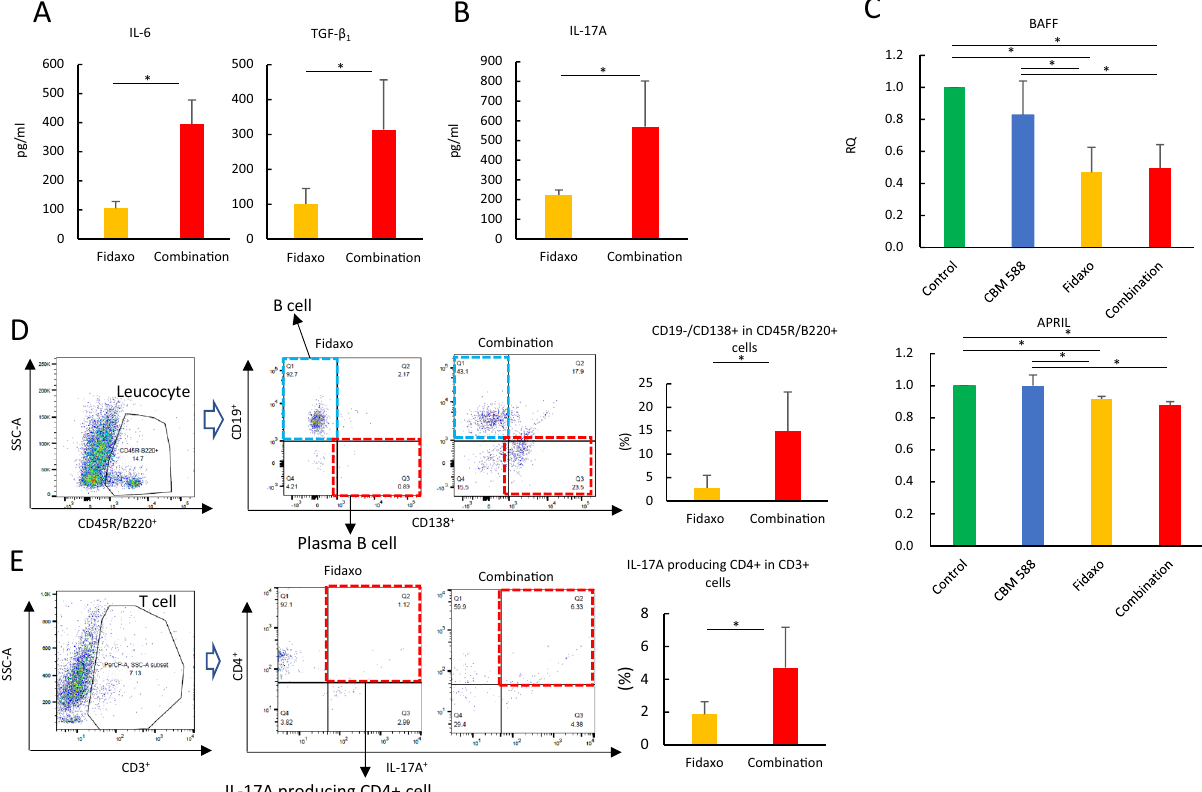
Figure 5. IL-17A plays important role to enhance antibacterial activity of combination therapy with C. butyricum against C. difficile and activate plasma B cell to enhance IgA production. ( A ) Interleukin (IL)-6, Transforming growth factor-β 1 (TGF-β 1 ) and ( B ) IL-17A protein expressions in mice colon lumina propria (cLP) detected at day 8. All values are mean ± SD (n = 5–10). ( C ) The relative RNA expression of genes encoding proliferation-inducing ligand (APRIL) and B-cell activating factor (BAFF) in colon tissues of mice, detected by qPCR. All values are mean ± SD (n = 5–10). ( D ) Representative flow cytometry plots of B cell (CD45R/ B220 + /CD19 + /CD138 - ) and plasma B cell (CD45R/B220 + /CD19 − /CD138 + ) expressions among leukocytes in the colonic lamina propria (cLP) in the fidaxomicin monotherapy group (Fidaxo), and combination group (Combination). Percentage of plasma B cell among leukocytes in cLP (right). ( E ) Representative flow cytometry plots of IL-17A producing CD4 + cell (CD3 + /CD4 + /IL-17A + ) expression among T cells in the cLP in the fidaxomicin monotherapy group (Fidaxo), and combination group (Combination). Percentage of IL-17A producing CD4 + cells among CD4 + cells among T cells in cLP